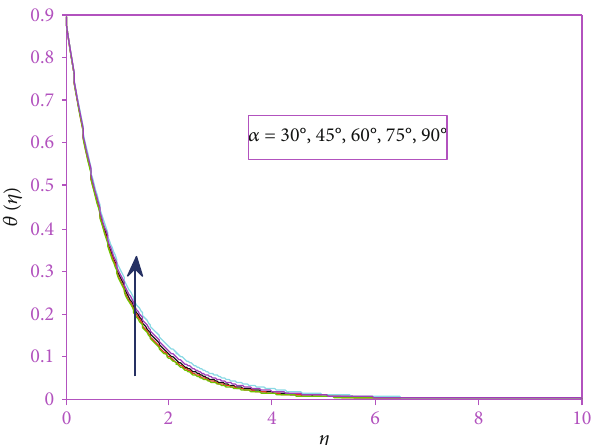
Figure 14: Temperature distribution for di ff erent values of the curvature parameter.